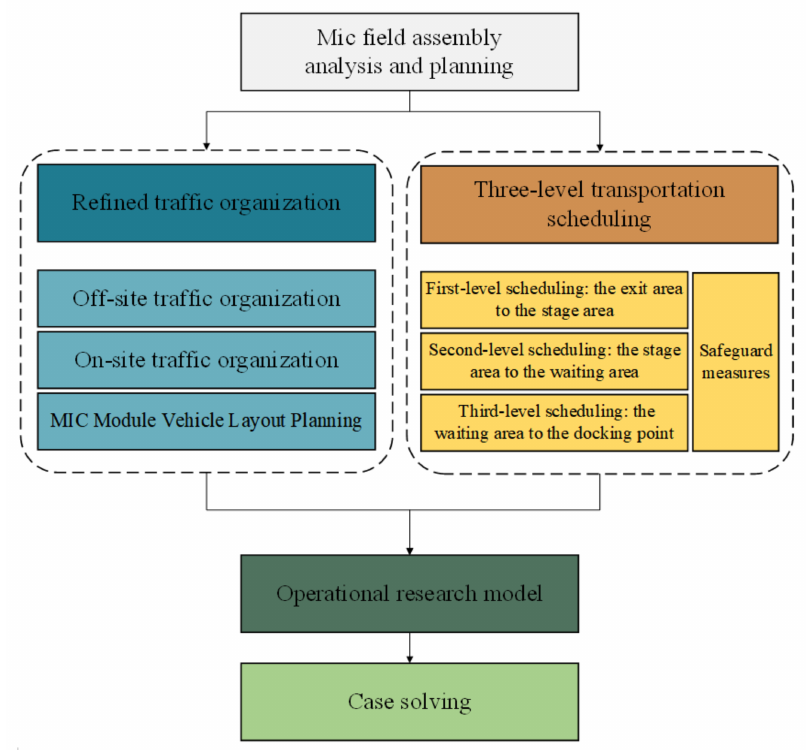
Figure 1. Research structure frame diagram.